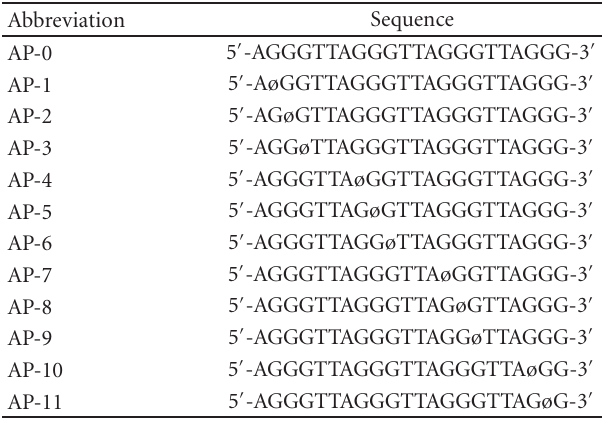
Table 1: DNA sequences used in this